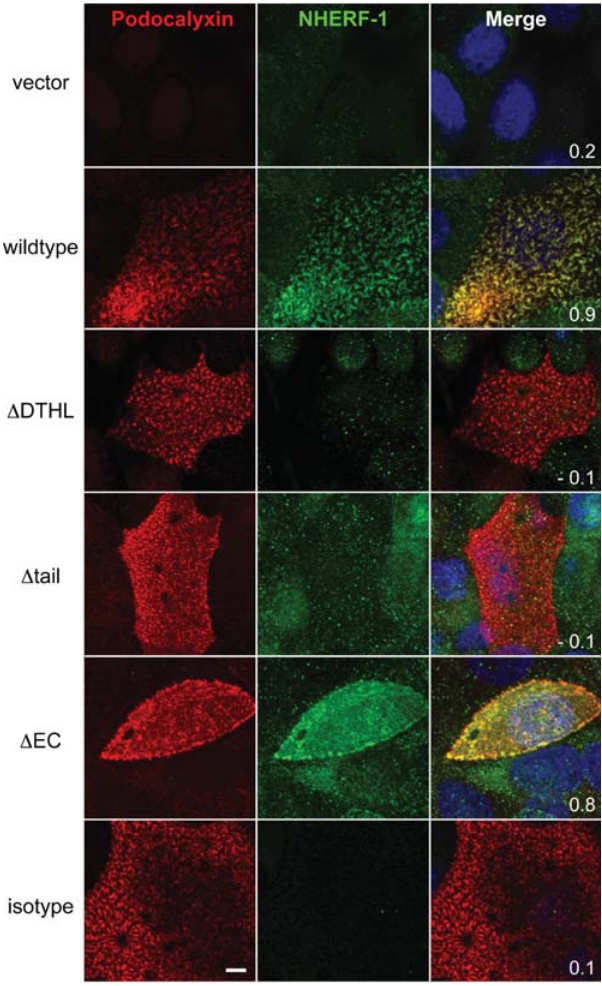
Figure 7. Podocalyxin’s C-terminal DTHL motif is required for recruitment of NHERF-1. Projections of apical confocal images of transfected MCF-7 cells showing ectopic Podocalyxin (red), endogenous NHERF-1 (green), and DAPI (blue) labeling. Isotype control sample is Podocalyxin-transfected cells labeled with anti-Podocalyxin (red) and NHERF-1 isotype control (green) to demonstrate lack of non-specific NHERF-1 staining. White numbers represent Pearson’s colocalization coefficient. Scale bar: 5 m m.